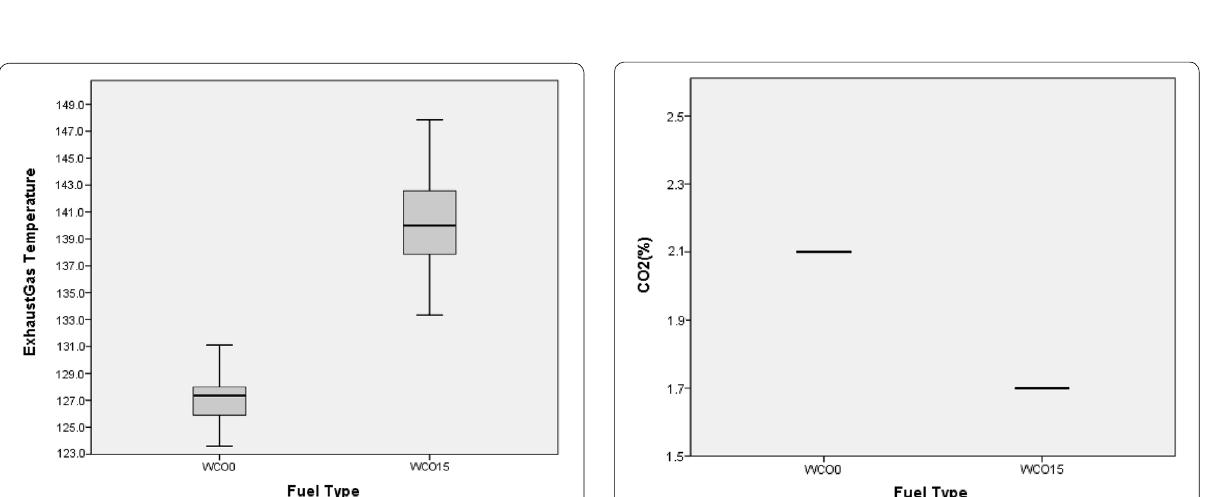
Fig. 4 Box plot diagrams of driving and exhaust characteristics [CO 2 emission (Unit: